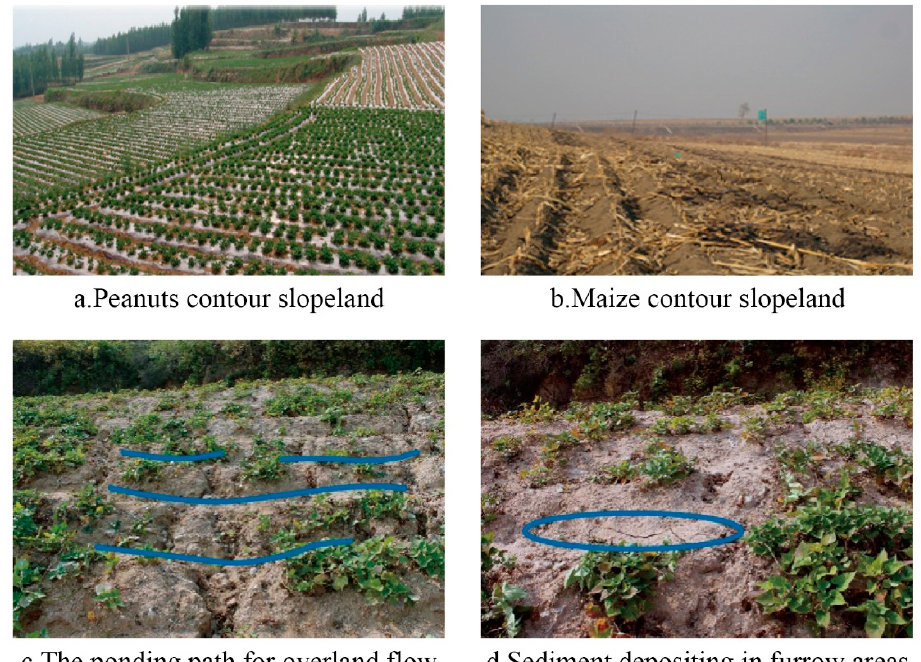
Figure 1. The application of contour ridge systems and erosion characteristics within contour ridge systems.